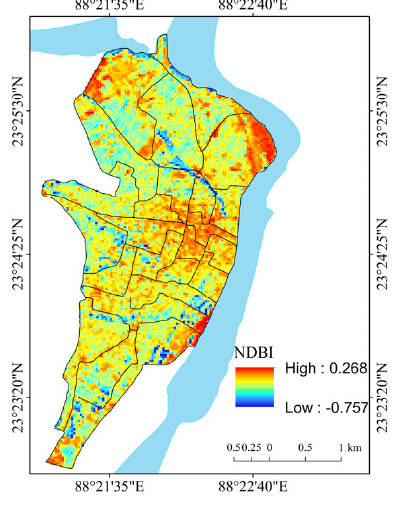
Figure 22. MNDWI (2000).